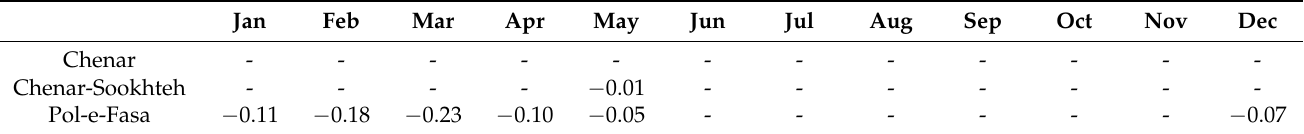
Table 9. Detected trend component in the monthly streamflow time series of selected stations.